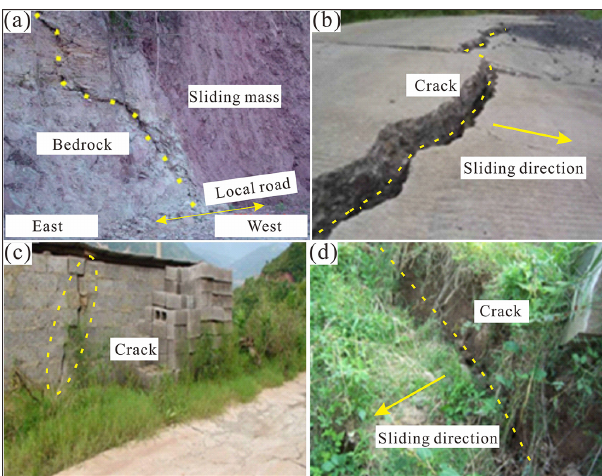
Figure 7. Photographs of the ground cracks in the landslide (Ren et al., 2015): (a) crack in the middle of the landslide on the outside of the local road, (b) failure state of the local road, (c) wall cracking and subsidence in the eastern portion and (d) the tension cracks in the eastern